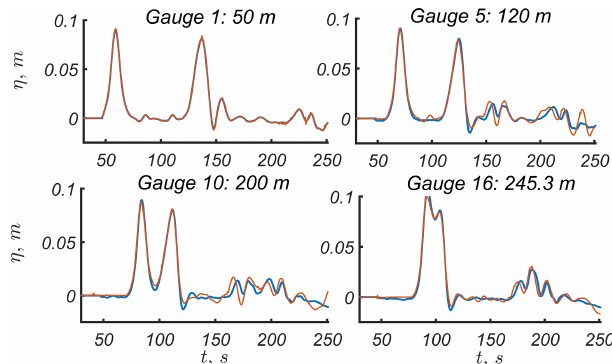
Figure 3. Run-up height of the long single wave with A = 0 . 1m and T = 20s on a beach slope, where tan α = 1 : 6. The numerical solution is shown by the red dotted line, the analytical solution is shown by the blue dashed line and the experimental record is shown by the black solid